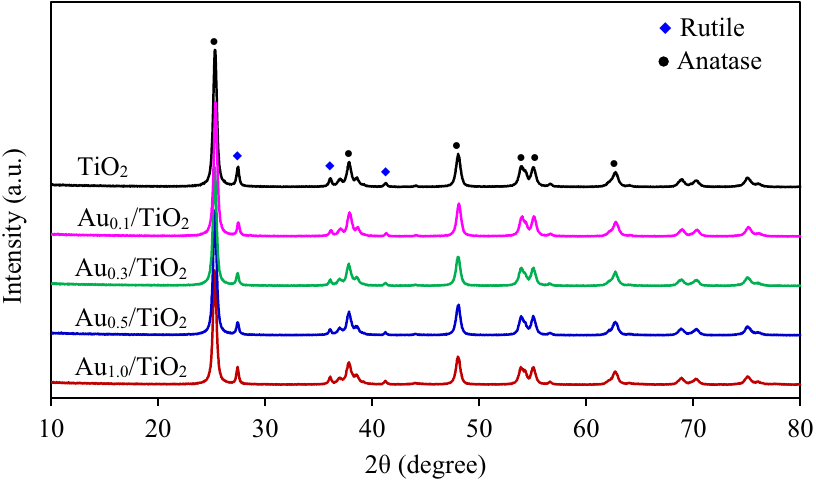
Figure 1. Representative XRD spectra of commercial TiO 2 and Au x /TiO 2 NPs synthesized by photodeposition at different Au loadings in the range of 0.1–1.0 wt%.